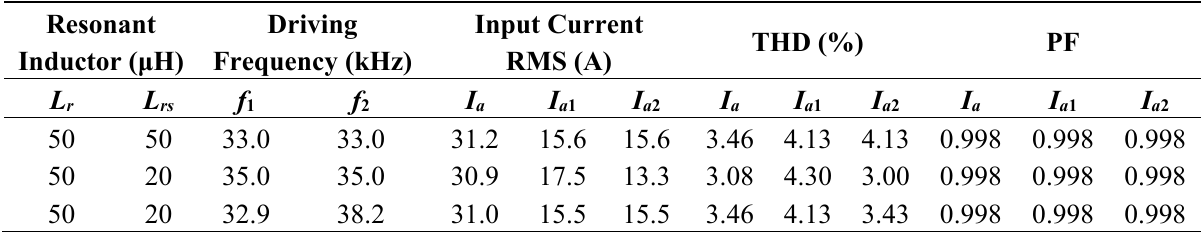
Table 4. Simulation results’ contrast under balanced and imbalanced current.